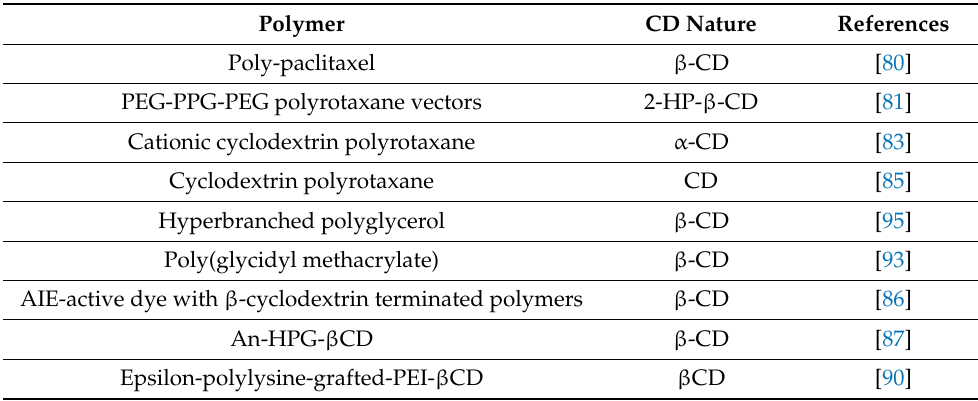
Table 1. Cyclodextrin-based polymers for theranostic nanomedicine techniques. Polymer CD